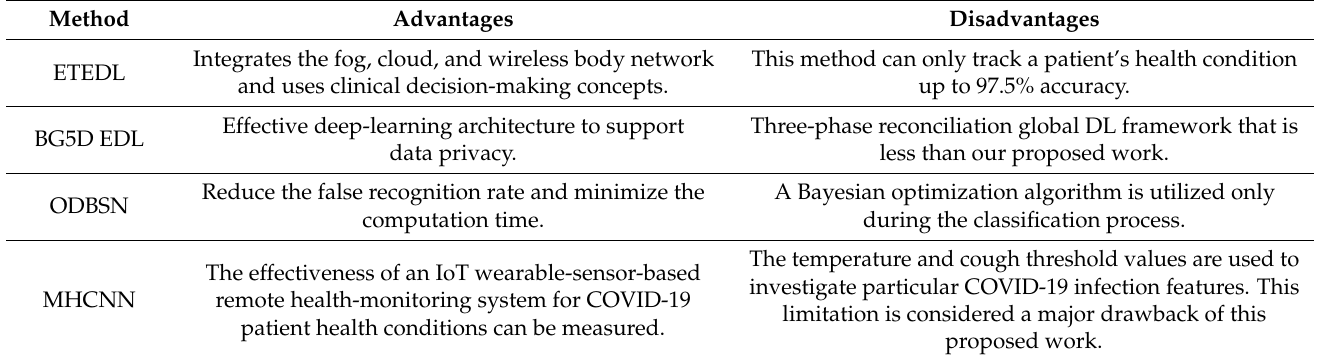
Table 1. Comparison analysis on conventional